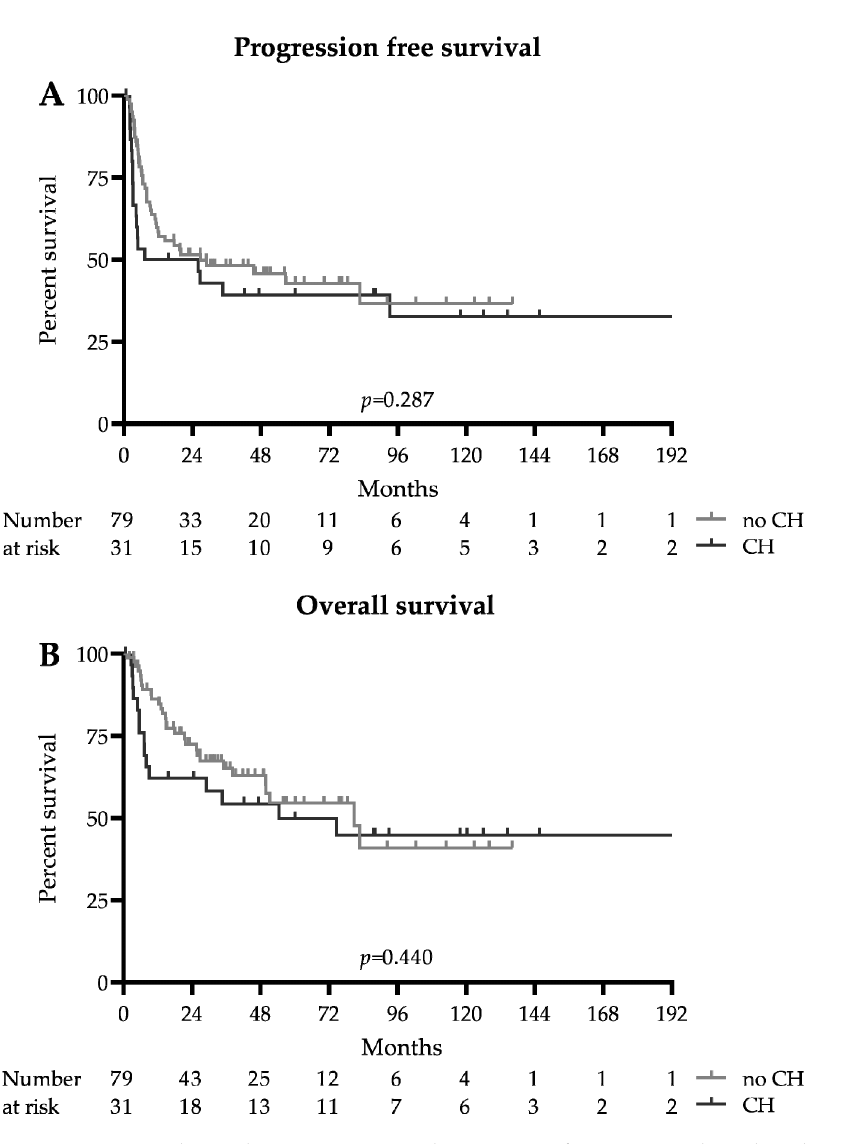
Figure 1. Survival: Kaplan–Meier survival estimates of patients with and without DTA clonal hem- atopoiesis (CH). ( A ) Progression-free survival. ( B ) Overall survival. Table 2. Outcome of patients according to DTA-CH (clonal hematopoiesis) status after autologous stem cell transplantation (ASCT). CR: complete